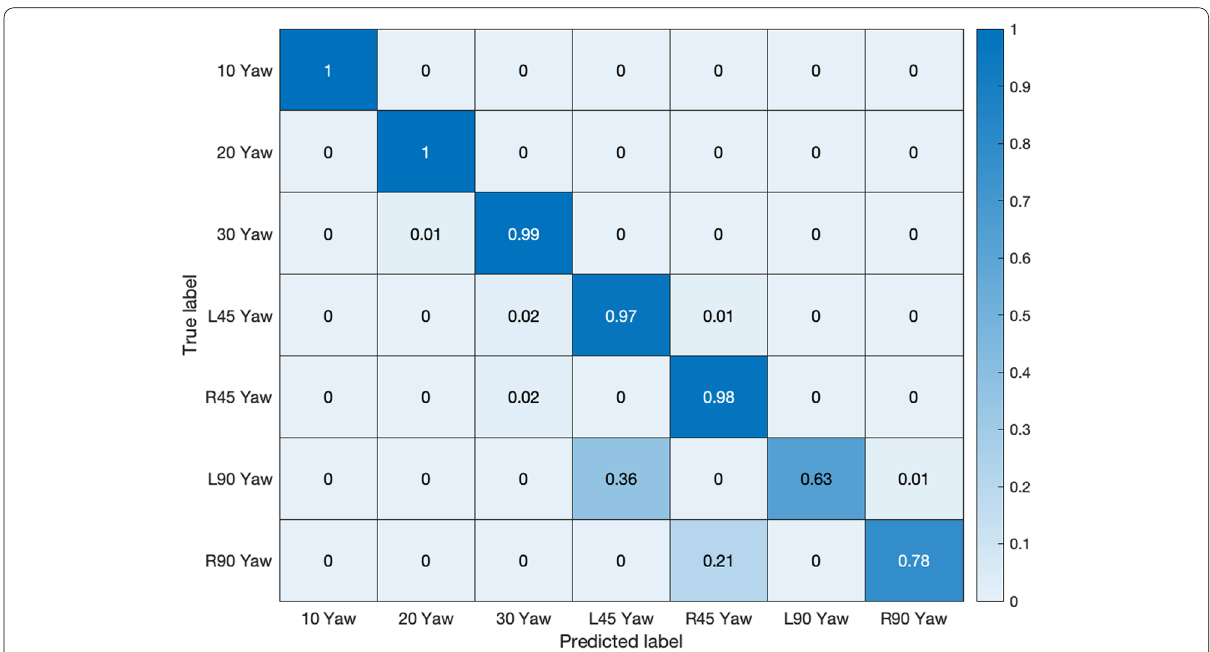
Fig. 12 Confusion matrix of pose prediction in Bosphorus